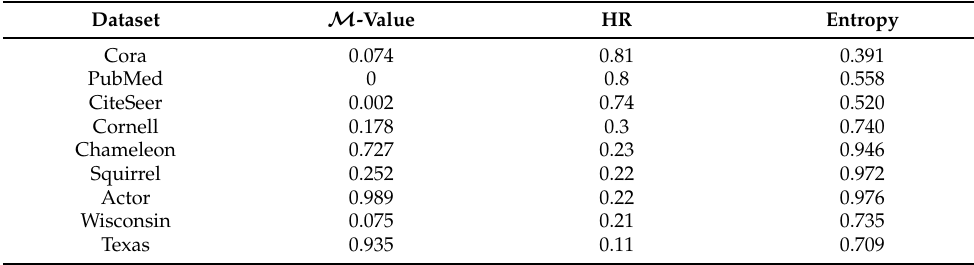
Table 6. M -value, homophily ratio, and edge information entropy of benchmark